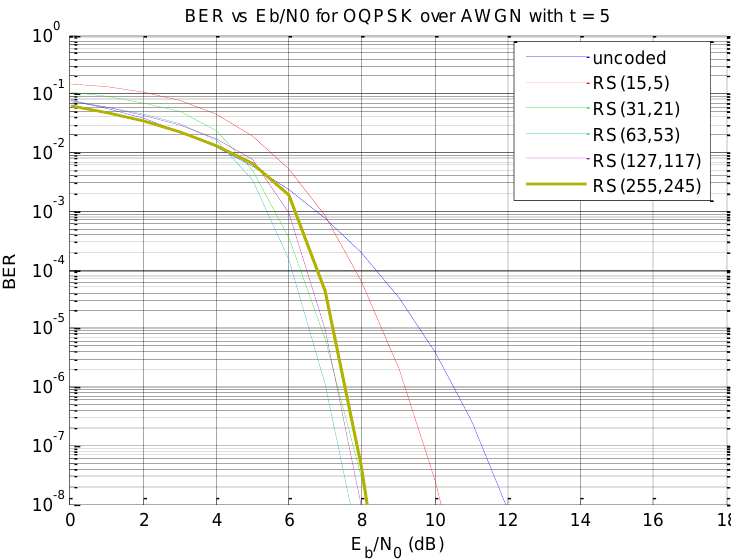
Figure 12. RS error performance for OQPSK over AWGN channel with t =5 and increasing n